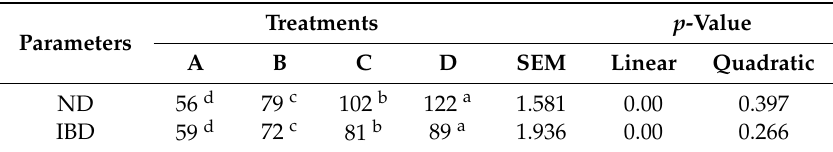
Table 5. Mean values of antibody titer against Newcastle disease (ND) and infectious bursal disease (IBD) per bird fed diets containing various levels of Toxin binder ( n = 10). Treatments p -Value Parameters A B C D SEM Linear Quadratic ND 56